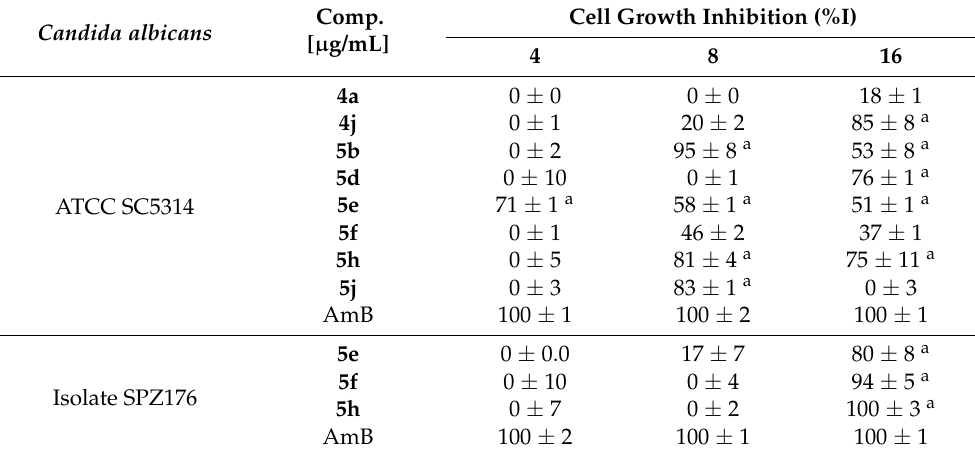
Table 2. In vitro antifungal activity of dibromobenzimidazole derivatives against C. albicans ATCC SC5314 and the randomly selected potential antifungals against C. albicans SPZ176 after 48 h. Comp. Candida albicans [ µ